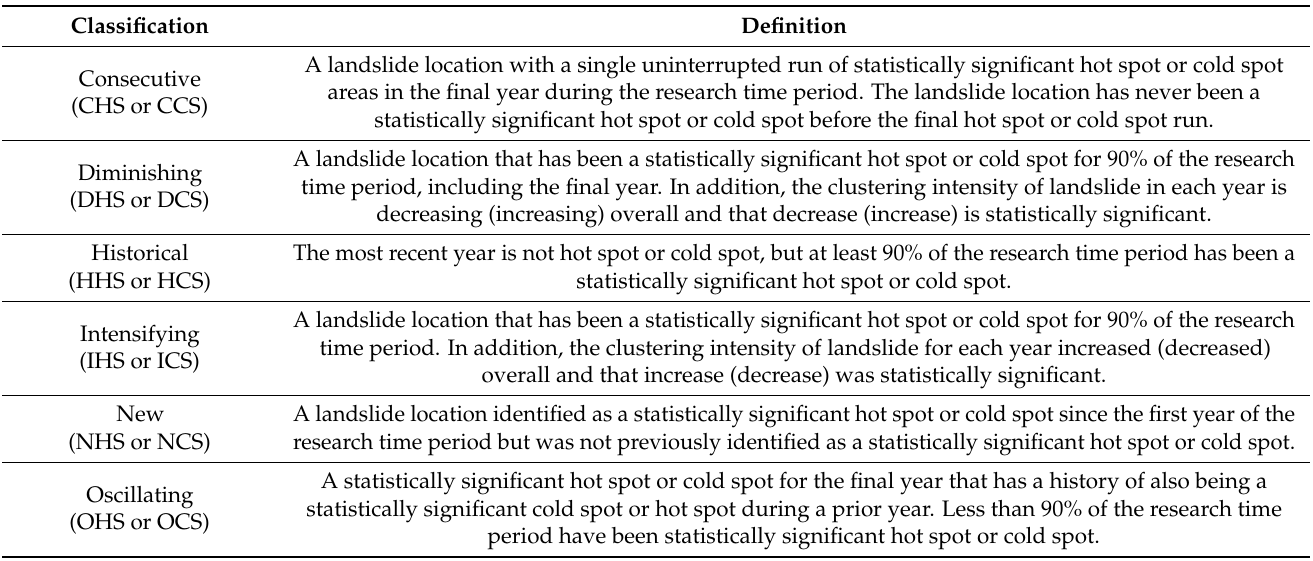
Table 1. The classifications and definition of emerging landslide hot spot and cold spot in the